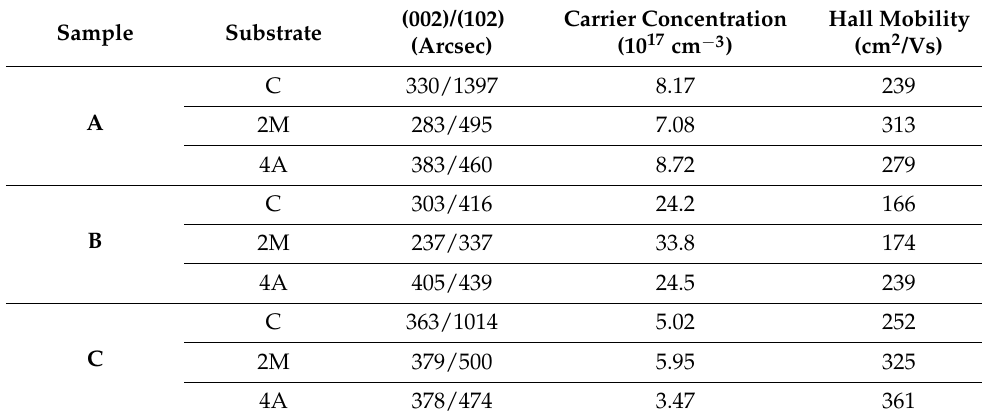
Table 2. Summary of the measured results for the total